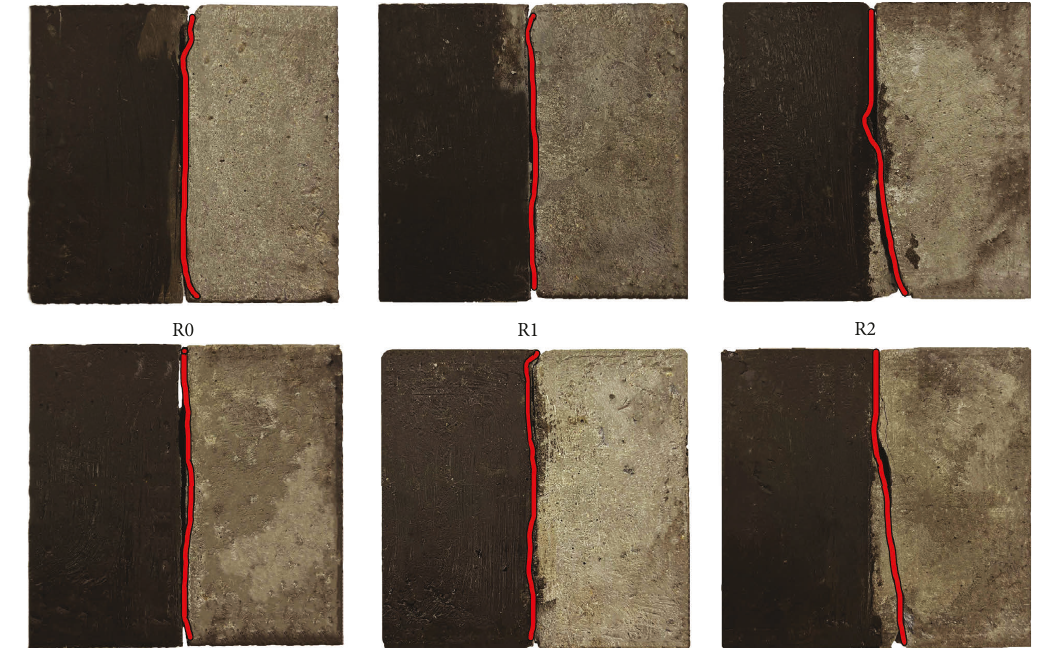
Figure 29: Bond oblique shear damage patterns.